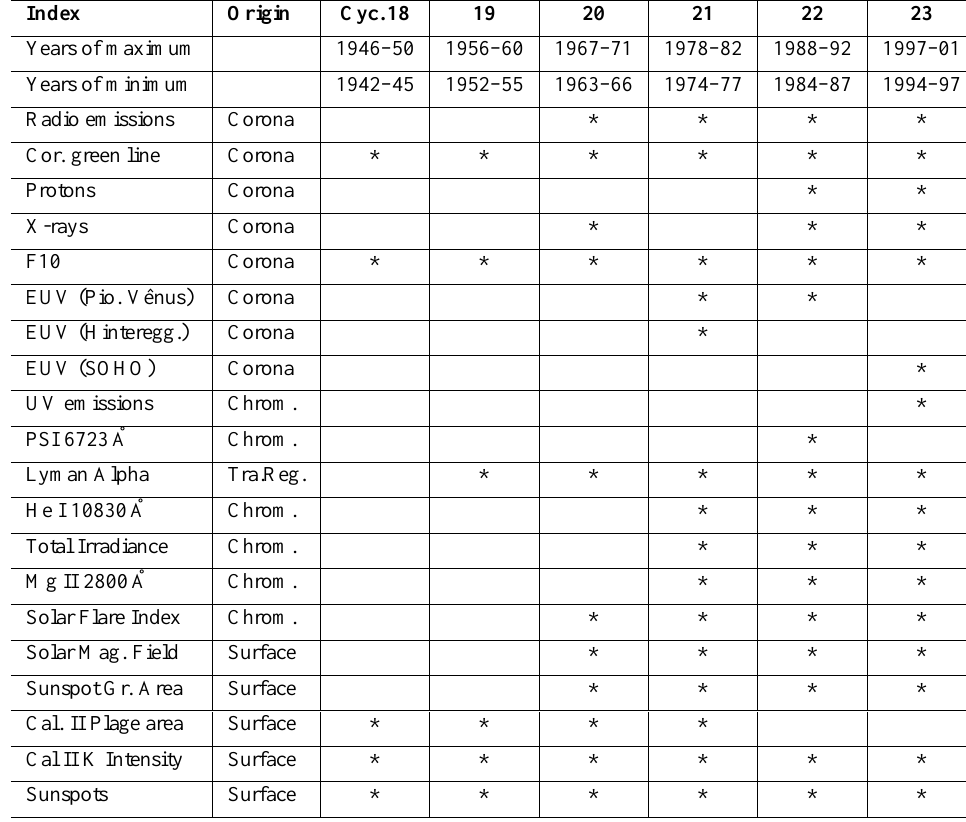
Table 1. List of solar indices used in the present